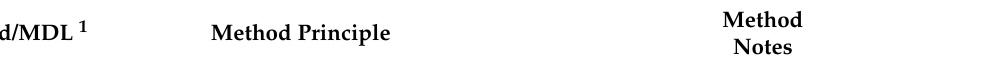
Table 2. Comparison of USEPA-approved methods for Ra